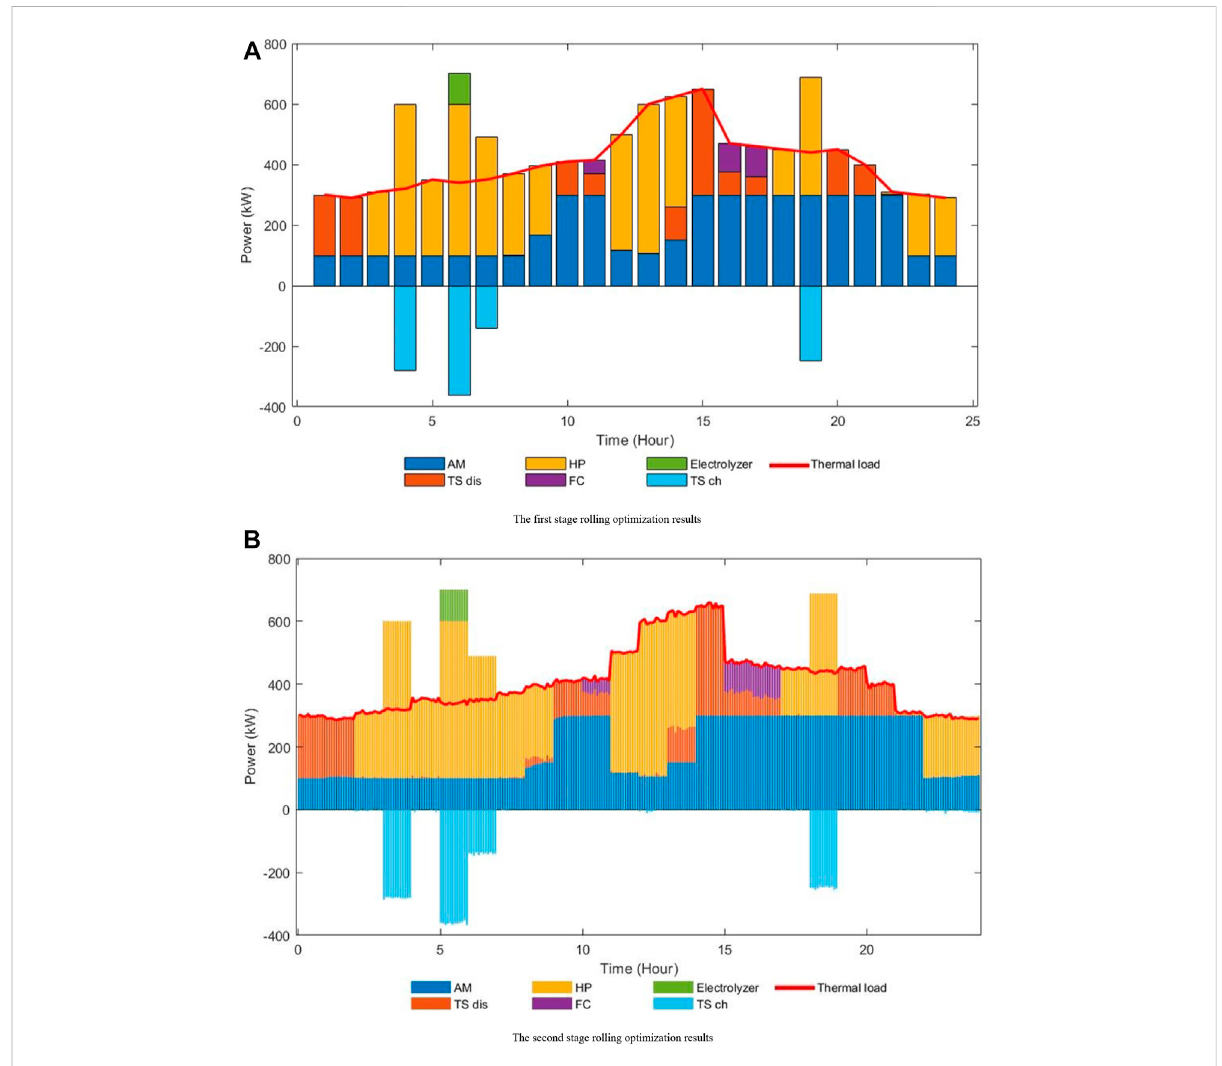
FIGURE 7 Summer thermal optimization results of MPC rolling optimization